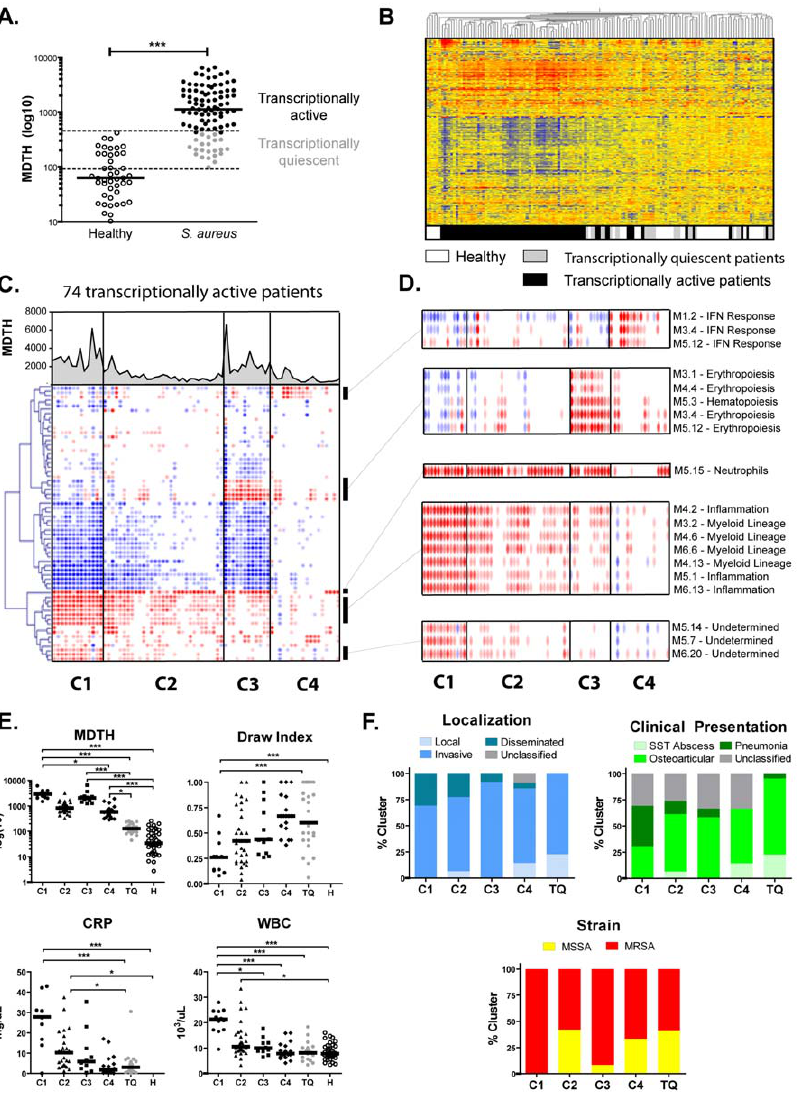
Figure 2. Individual analysis identifies heterogeneous components of the blood signature to S. aureus . A. Column scatter plot representing the distribution of individual molecular distance to health (MDTH) in healthy controls and S. aureus patients. The list of all transcripts composing the modules was used as reference to calculate individual MDTH (***: p , 0 . 001, Mann-Whitney). Horizontal bars represent the group median. Patients with MDTH within healthy range (n=25) were categorized as transcriptionally quiescent (TQ) and represented in grey. B. Unsupervised hierarchical clustering of the 10,972 transcripts expressed in at least one of the 143 samples (2-fold normalized, 100 difference in raw data) from the combined training and test sets. C. The modular signature was derived for individual transcriptionally active patients (n=74) as compared to the median of the healthy control group for the corresponding patient set (training or test). Four major clusters (C1 through C4) of patients were obtained by K-means clustering and reorganized into a single heatmap, with modules in rows and patients in columns. Molecular distance to health for individual samples is represented as a line chart on top of the heatmap. D. Zoom on modules with specific over-expression patterns across the four clusters. E. MDTH and clinical lab measurements distribution by cluster. Five or six-group non-parametric ANOVA (Kruskal- Wallis) with Dunn’s post-hoc test was applied. (*: p , 0.05, **: p , 0.01, ***: p , 0.001). F. Bar charts representing the percent distribution of infection localization, clinical presentation and bacterial strain for the five clusters of patients